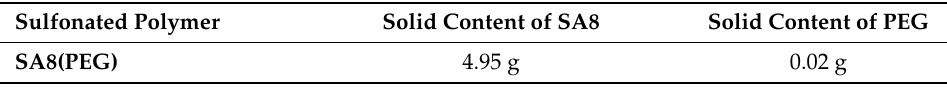
Table 3. Solid contents of SA8 and sPEEK.